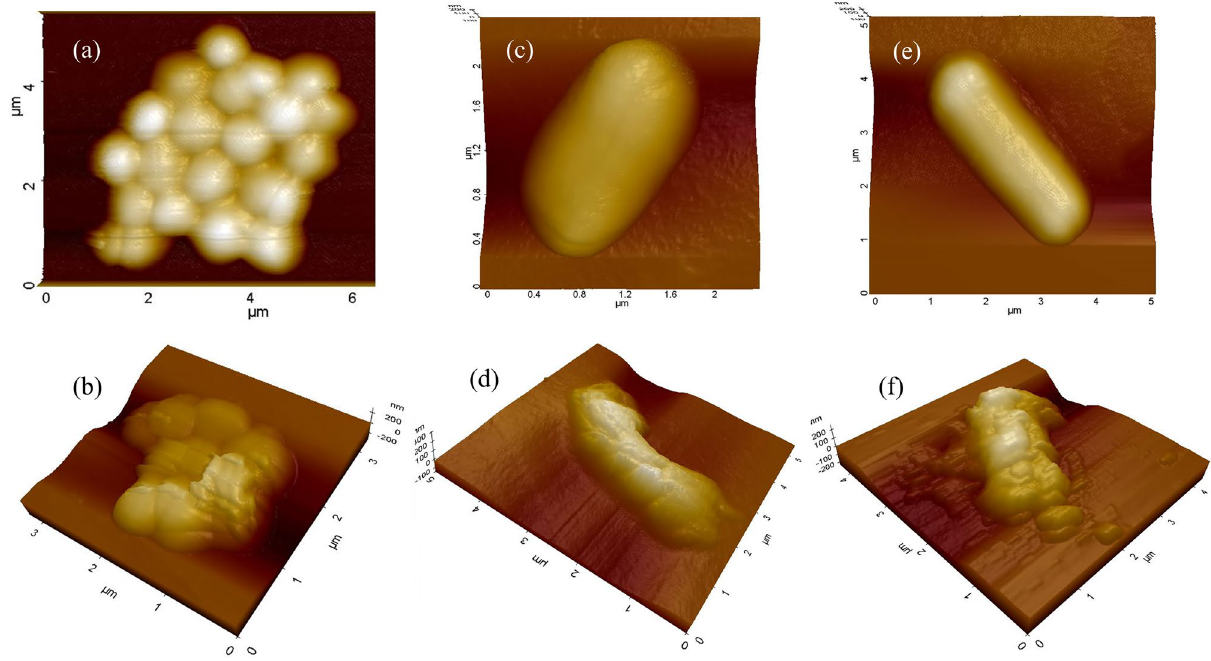
Figure 3. AFM images of VRE, MRAB and C. difficile spores ( a , c, e ) untreated and ( b , d , f ) treated with ozone at 500 ppm for 15 min. The images were plotted using the XEI program of Park Systems version 5.1.6 (XEI software, Suwon, Korea; https:// www. parks ystems. com/ 102- produ cts/ park- xe-